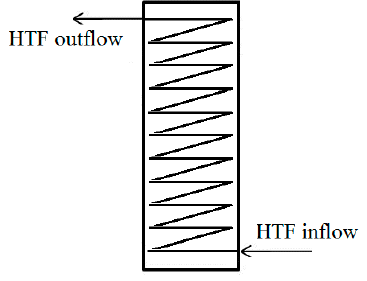
Figure 4. Sketch of the cold water storage tank.